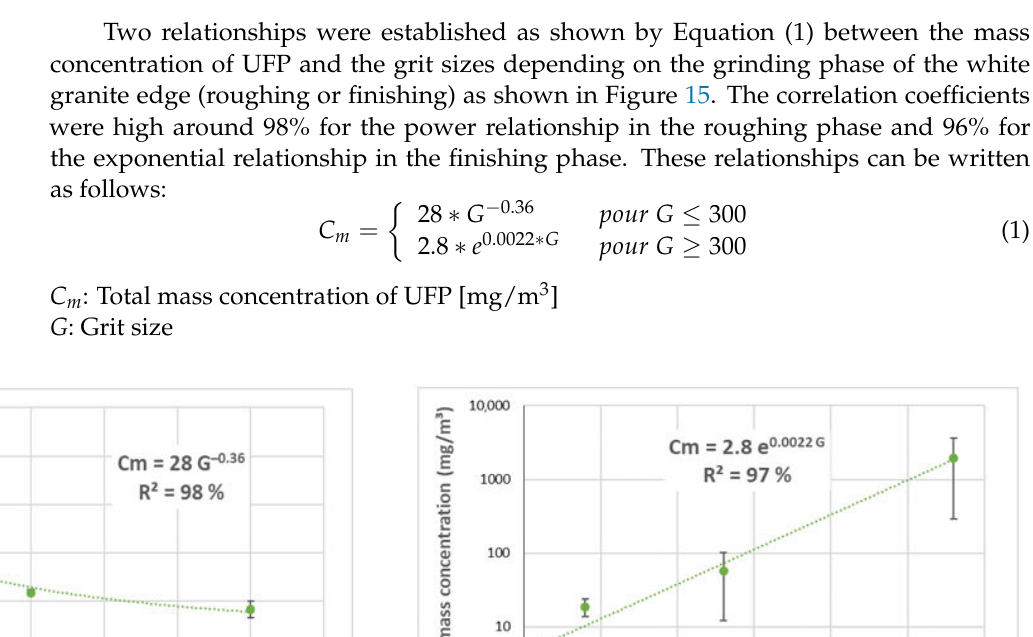
Figure 14. Total mass concentration of UFP while grinding white granite for different grit sizes (Vs = 3500 rpm; f = 1000 mm/min).